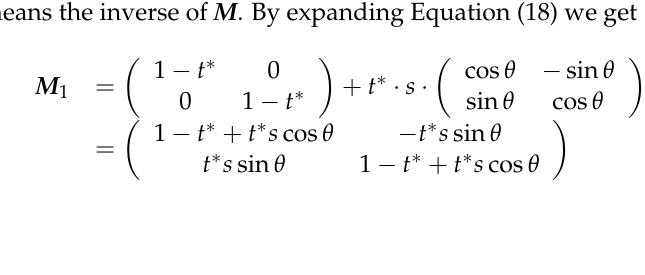
Figure 10. Subdivision of a cubic typical B é zier curve at curvature